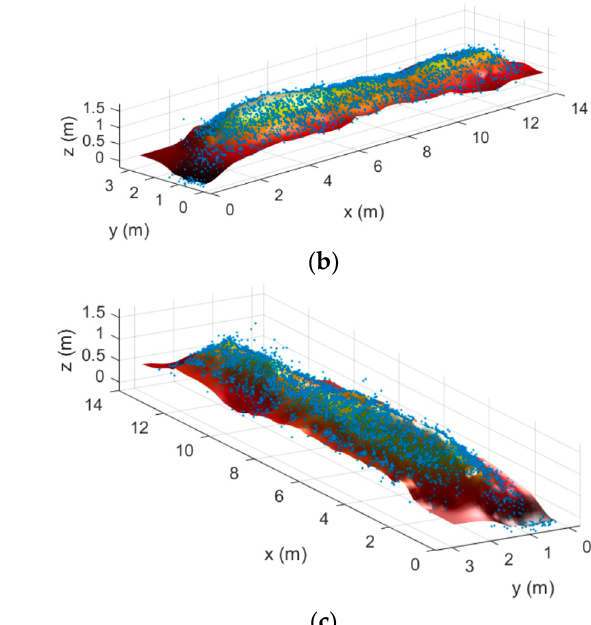
Figure 11. Surface reconstruction of the real stockpile from different perspectives.